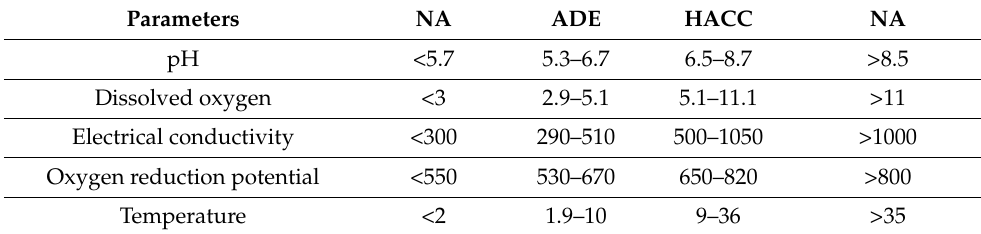
Table 3. The range of water quality parameters for each membership functions (MF): not acceptable (NA), adequate (ADE) and highly acceptable (HACC) [63]. Reprinted with permission from Bhardwaj, J.; Gupta, K.K.; Gupta, R.; 2018. Parameters NA ADE HACC NA pH <5.7 Dissolved oxygen <3 Electrical conductivity <300 Oxygen reduction potential <550 Temperature